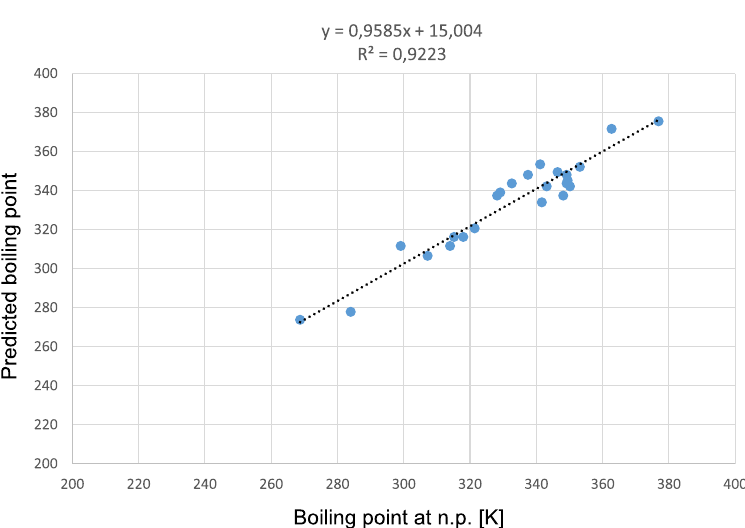
Figure 6. Boiling points and predicted boiling points for all considered